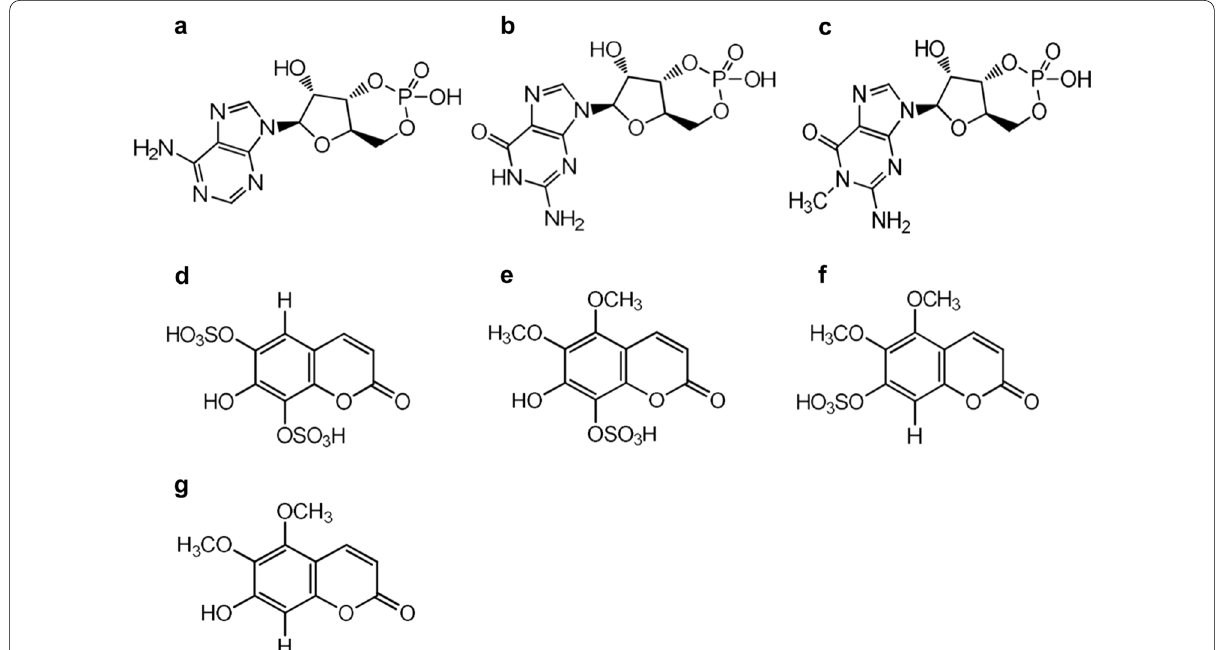
Fig. 3 Chemical structure of 7 peaks for chemical profile. Adenosine 3 ′ ,5 ′ -cyclic monophosphate ( a ), Guanosine-3 ʹ ,5 ʹ -cyclomonophosphate ( b ), 1-Methyl guanosine-3 (umckalin, g )